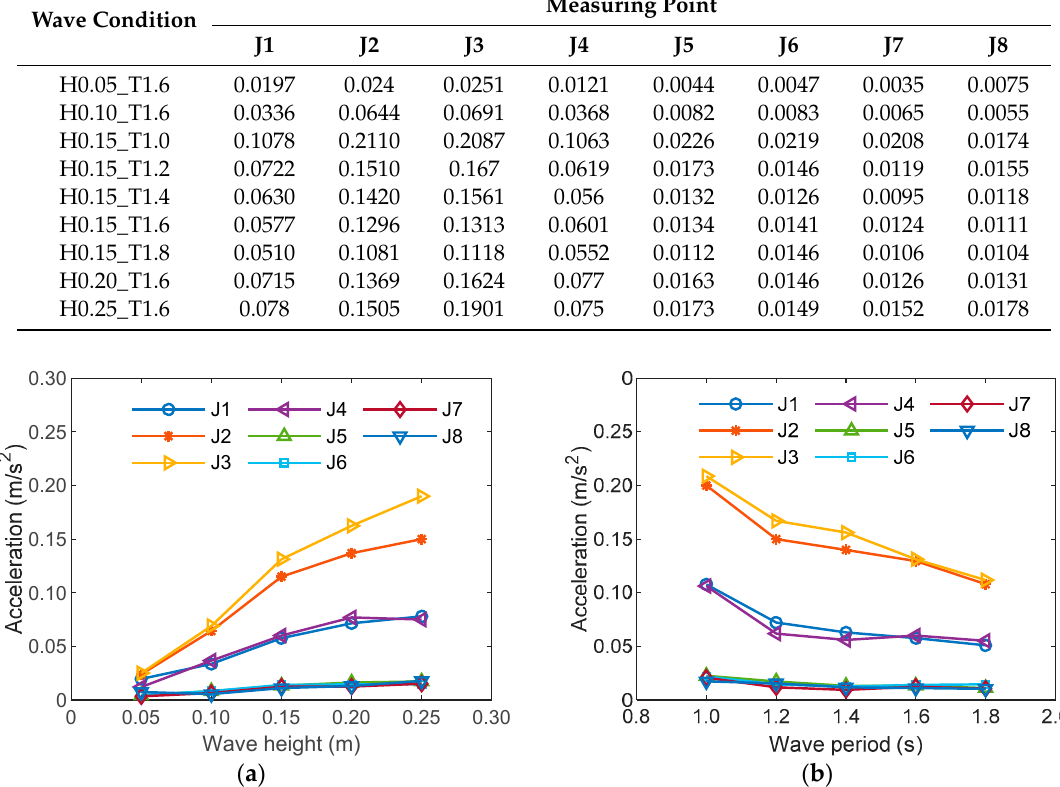
Figure 10. The peak accelerations at various measurement positions in waves. ( a ) Variation with wave height when wave period T = 1.6 s; ( b ) Variation with wave period when wave height H = 0.15 m.